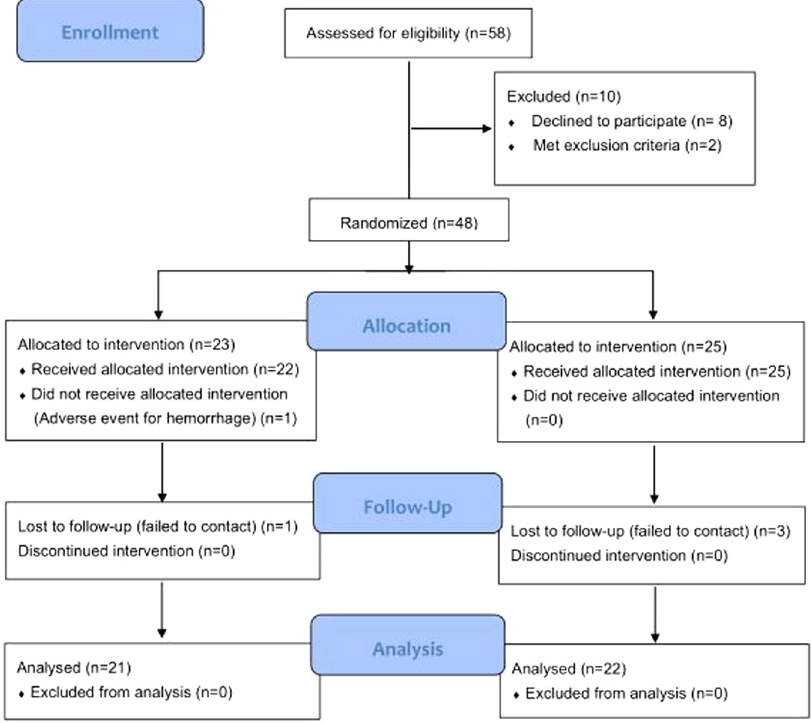
Figure 6. CONSORT 2010 Flow Diagram 19 .